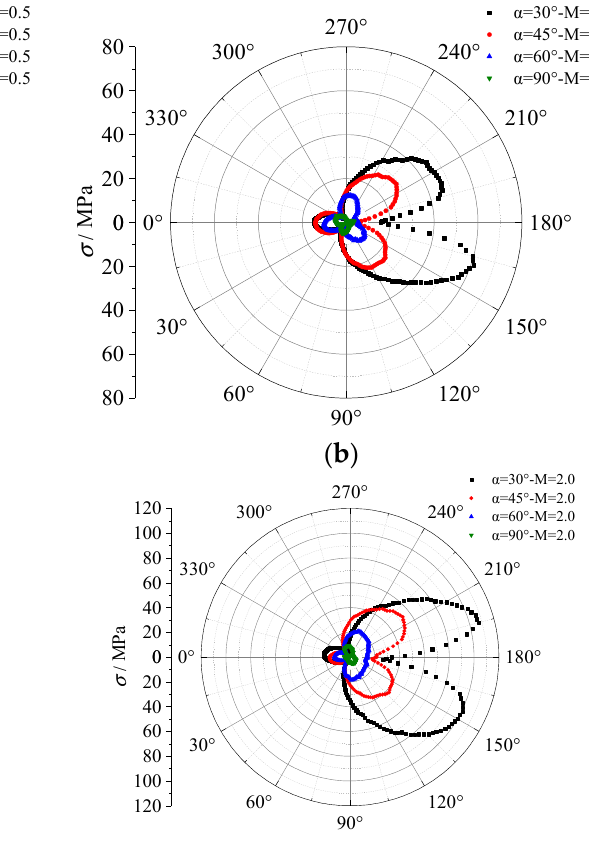
( c ) M = 1.5. ( d ) M = 2.0.